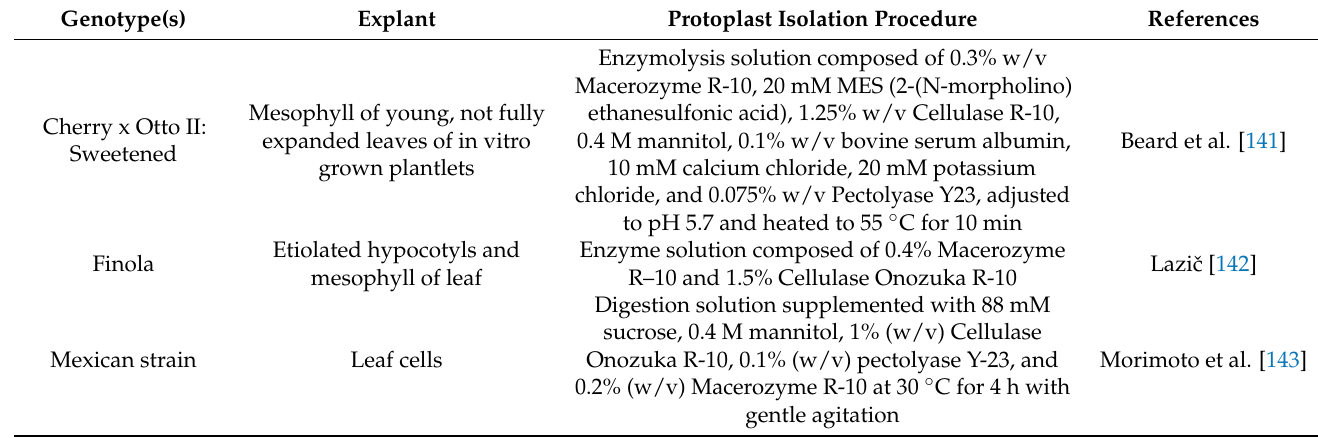
Table 3. Protoplast isolation studies in